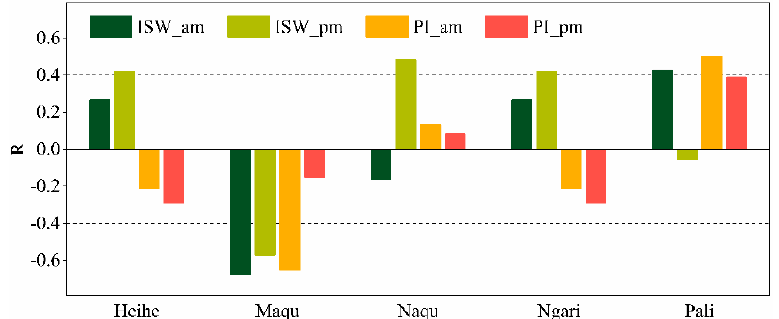
Figure 8. Comparison of the R values between the polarization index (PI) or index of soil wetness (ISW) and in situ T s for the morning and afternoon orbits from 2012 to 2016 in the five networks.